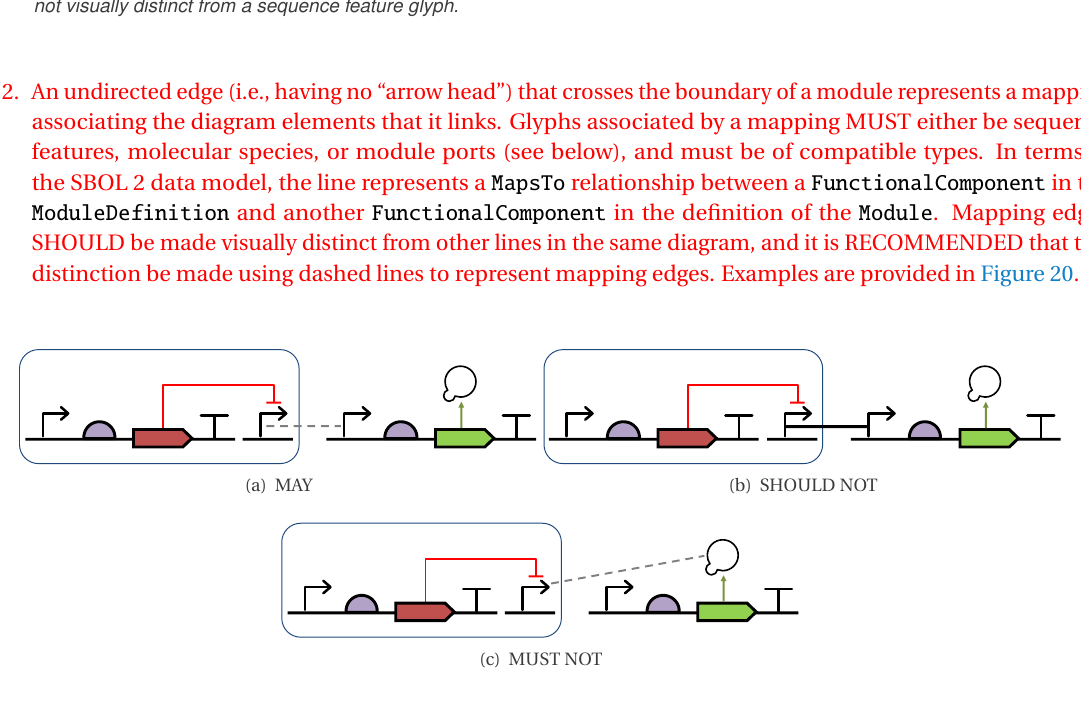
2. An undirected edge (i.e., having no “arrow head”) that crosses the boundary of a module represents a mapping